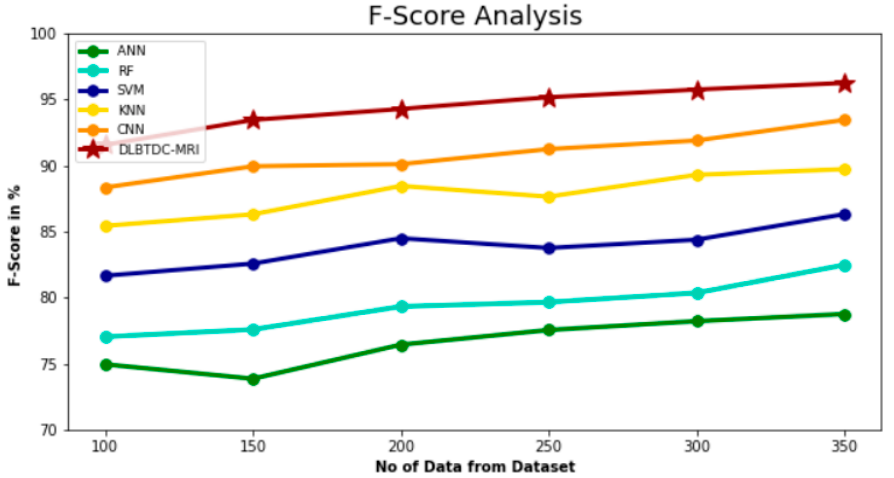
Figure 6. F-Score analysis of DLBTDC-MRI method with existing Figure 5. F-Score analysis of DLBTDC-MRI method with existing system.